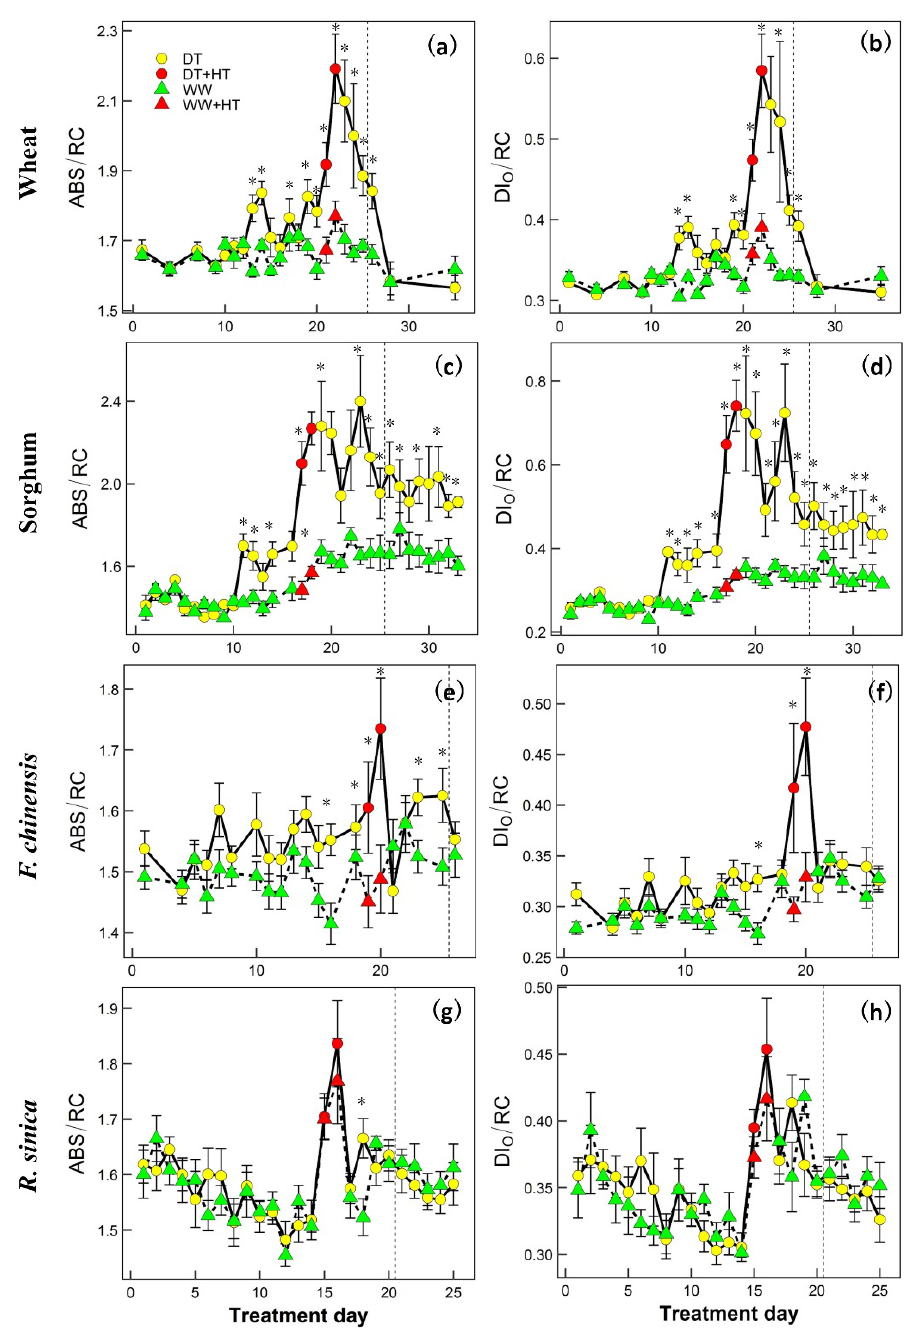
Figure 5. Time series responses of two representative chlorophyll fluorescence OJIP parameters: Φ P O (quantum yield of primary photochemistry (Panels ( a , c , e , g )) and PI abs (performance index on an absorption basis (Panel ( b , d , f , h )) which were downregulated by drought and/or heat stress in wheat ( a , b ), sorghum ( c , d ), F. chinensis ( e , f ) and R. sinica ( g , h ). Plants were maintained under either drought (DT) or well-watered (WW) conditions and subjected to 2-day heat stress (HT) during the drought period. The dashed vertical line represents re-watering of the DT plants. Data show the mean ± S.E. of four replicates (n = 4). At each time point, ‘*’ indicates significant differences between the data for plants maintained under drought and well-watered conditions from one-way analysis of variances ( p < 0.05).